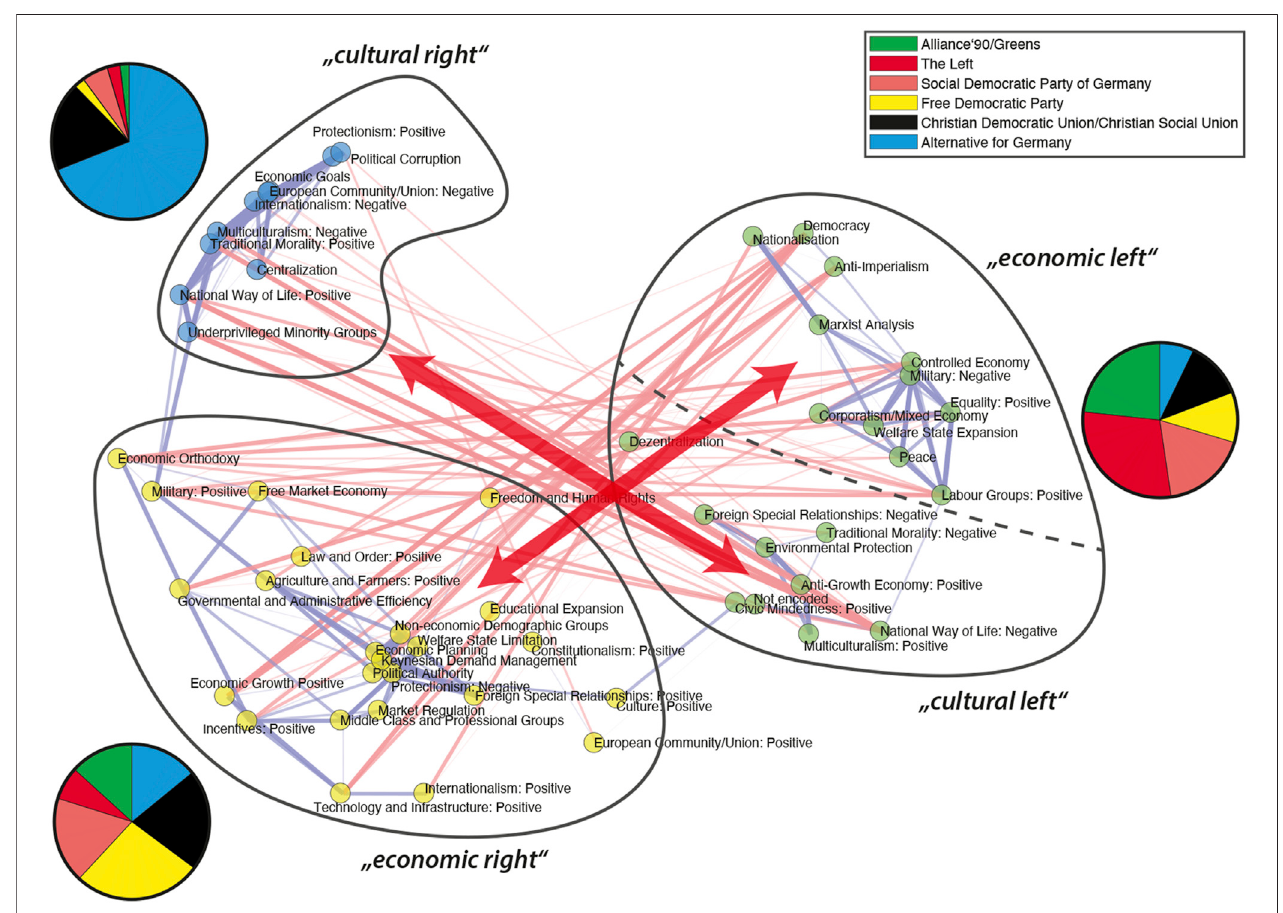
FIGURE 12 | IICN for the German elections in 2017. Blue links encode strong positive correlations and red links negative ones. Only correlations signi fi cant at the 10%-level ( p < 0.1) are shown and the thickness of an edge re fl ects signi fi cance and strength of the correlation. The three subsets of categories corresponding to the three different issue bundles are highlighted and the coverage by the different parties is